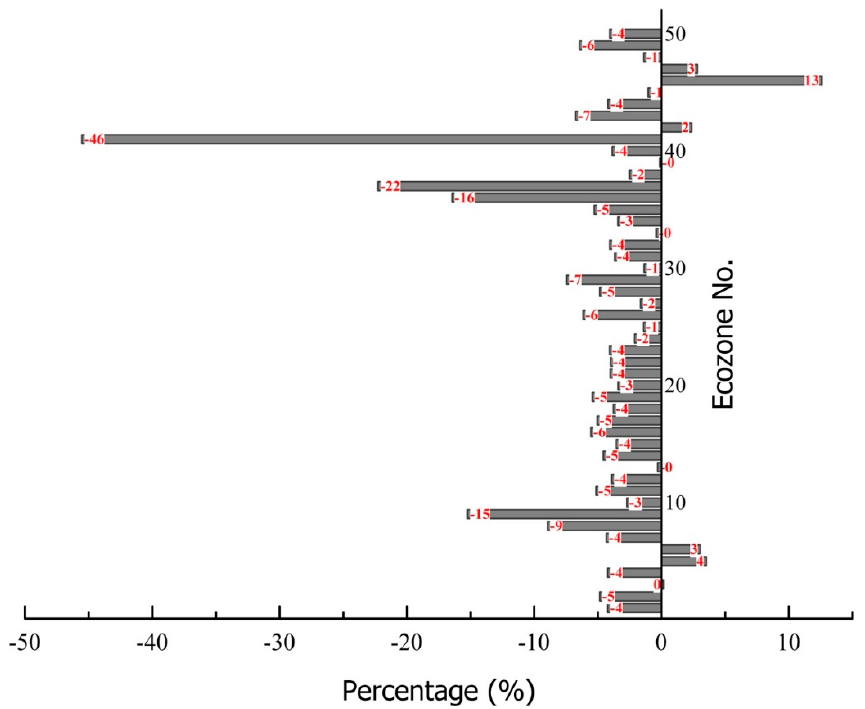
Figure 9. Changes after combined PALSAR of uncertainty in 50 ecozones. Red represents the value of the uncertainty of change in each ecozone.